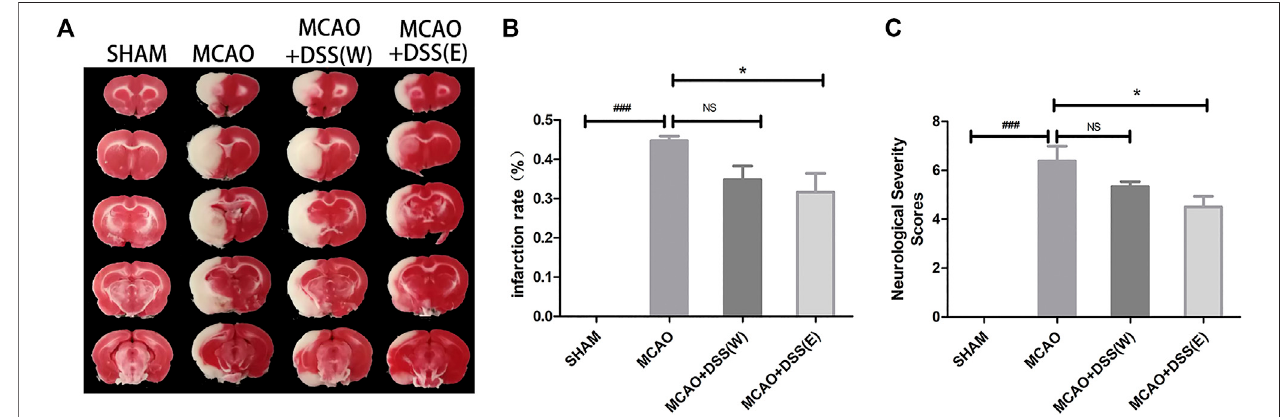
FIGURE 1 | Effects of DSS ethanol extract [DSS(E)] and aqueous extract [DSS(W)] on infarction sizes and neurological de fi cit scores in post MCAO ischemic rats. S.D.ratswereallocatedintogroupsofsham control,MCAO,andMCAO+DSS(W) andMCAO+DSS(E).TheratsforMCAOorMCAOplusDSStreatmentgroupwere subjected to 2 h of MCAO ischemia plus 22 h of reperfusion. Aqueous and ethanol extracts of DSS at the dosage of 12 g/kg was orally administrated into the rats at 30 min before reperfusion after 1.5 h MCAO ischemia. Sham: sham control group; MCAO: the rat group was subjected to 2 h of MCAO ischemia plus 24 h of reperfusion; MCAO + DSS (E): MCAO plus DSS ethanol extract treatment (12 g/kg). MCAO + DSS (W): MCAO plus DSS aqueous extract treatment (12 g/kg). Infarct sizesandneurologicalde fi citscoreswereevaluated. (A) RepresentativebrainslicesofTTCstainingforinfarctsizes.Thewhitecolorarearepresentsbraininfarctionarea. (B) StatisticalanalysisofinfarctsizesasmeasuredbyusingImageJsoftware, n (cid:2) 8 – 9,vs.MCAO,* p < 0.05. (C) Neurologicalde fi citwasmeasuredbyusingthemodi fi ed Neurological Severity Scores (mNSS) in each group at 24 h after MCAO ischemia, n (cid:2) 8 – 9, vs. MCAO * p <